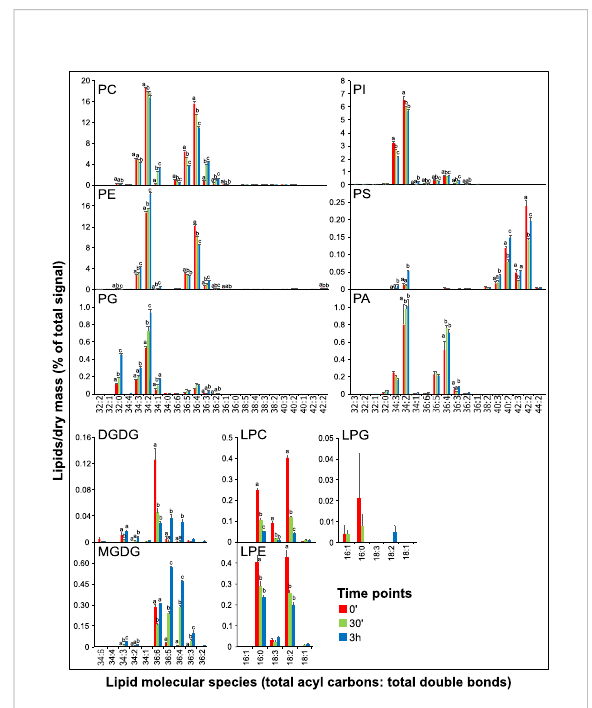
FIGURE 3 Changes in lipid molecular species during tobacco pollen germination and pollen tube elongation. Data are presented as mean ± s.e.m., n=4 (0 ’ ) and n=5 (30 ’ and 3h). Different letters indicate signi fi cant differences between samples at p <